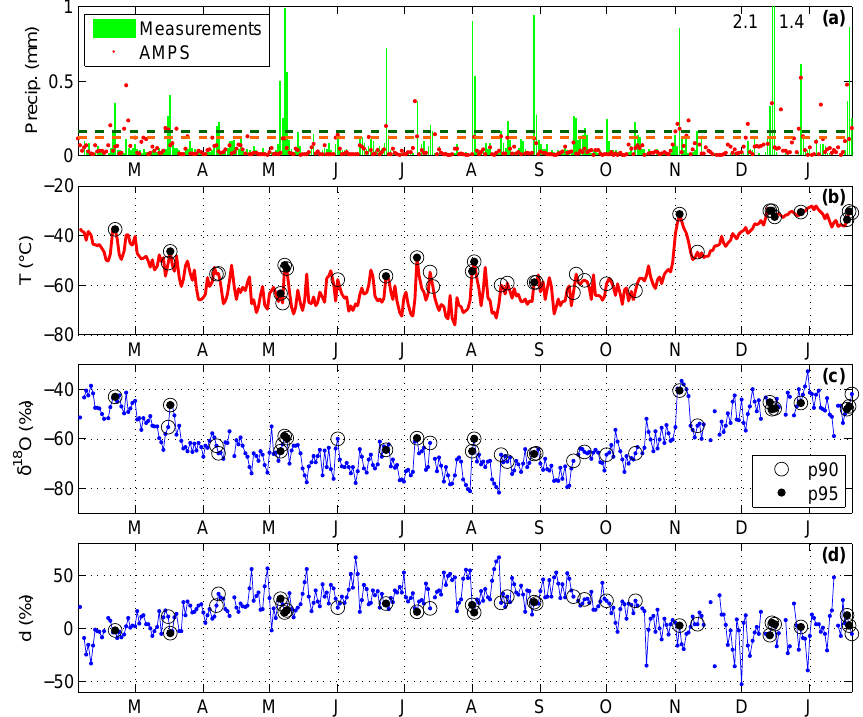
Figure 2. (a) Measurements and AMPS simulations of daily precipitation in mmw.e. Green dashed line: 90% percentiles from measure- ments. Orange dashed line: 90% percentile from AMPS. (b) Daily measurements of temperature, (c) daily measurements of δ 18 O, and (d) daily measurements of deuterium excess. The open and filled circles in panels (b–d) mark the days where the precipitation exceeded the 90 and 95% percentiles respectively. The 90% percentile is defined as the threshold for precipitation events.